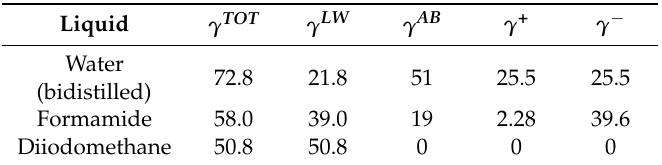
Table 8. Surface free energy and its component values for the used liquids; all values are expressed in mN/m.